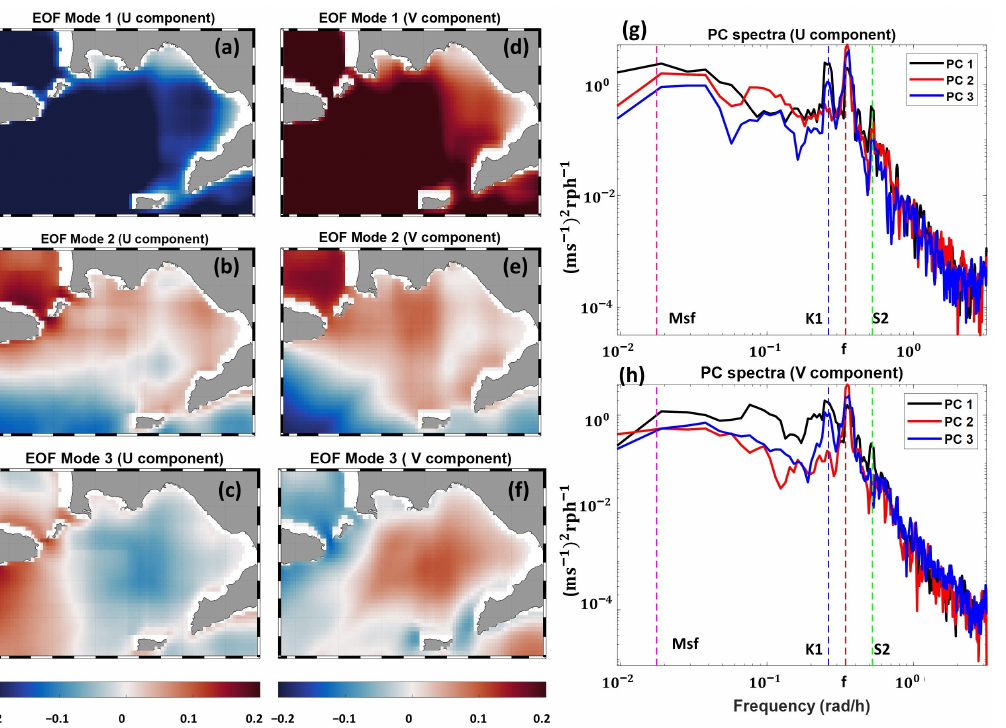
Figure 15. Spatial pattern of 3 EOF modes ( a – f ) for the simulated surface current field in May 2016. Frequency spectra of the expansion coefficient associated with the 3 principal modes for the zonal ( g ) and meridional ( h ) components.